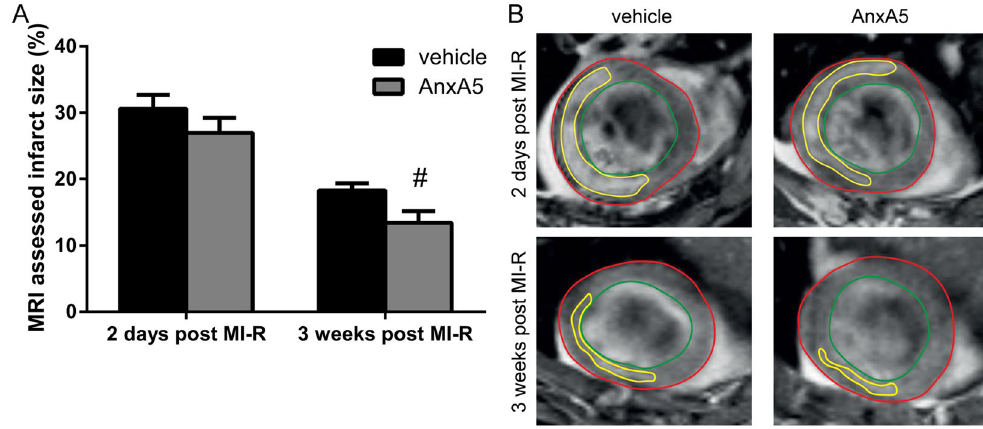
Figure 2. Contrast-enhanced MR imaging. Two days after MI-R no difference in infarct size was observed between the groups (n = 13–15). However, after three weeks the AnxA5 group displayed a reduced infarct size as compared to the vehicle group ( A ). Representative Gd-DPTA-enhanced MR images ( B ) two days and three weeks after MI-R of the vehicle and AnxA5 group, red line indicates epicardial border, green line indicates endocardial border and yellow line indicates infarct area. Data are mean ± SEM. # P < 0.05 vs.